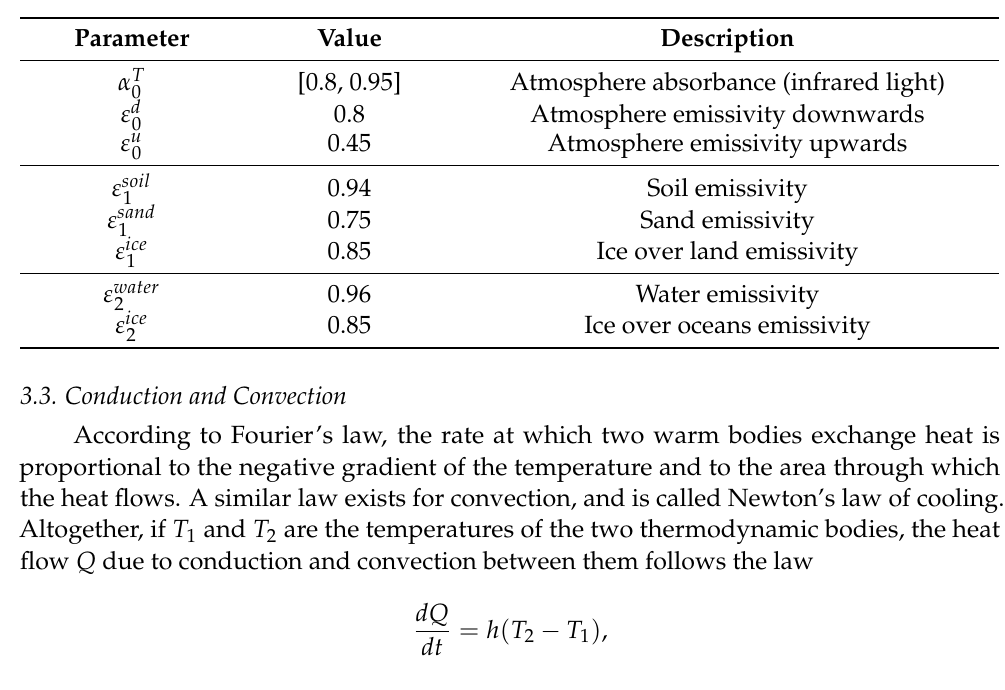
to thermal radiation and emissivity ε for various thermodynamic 0